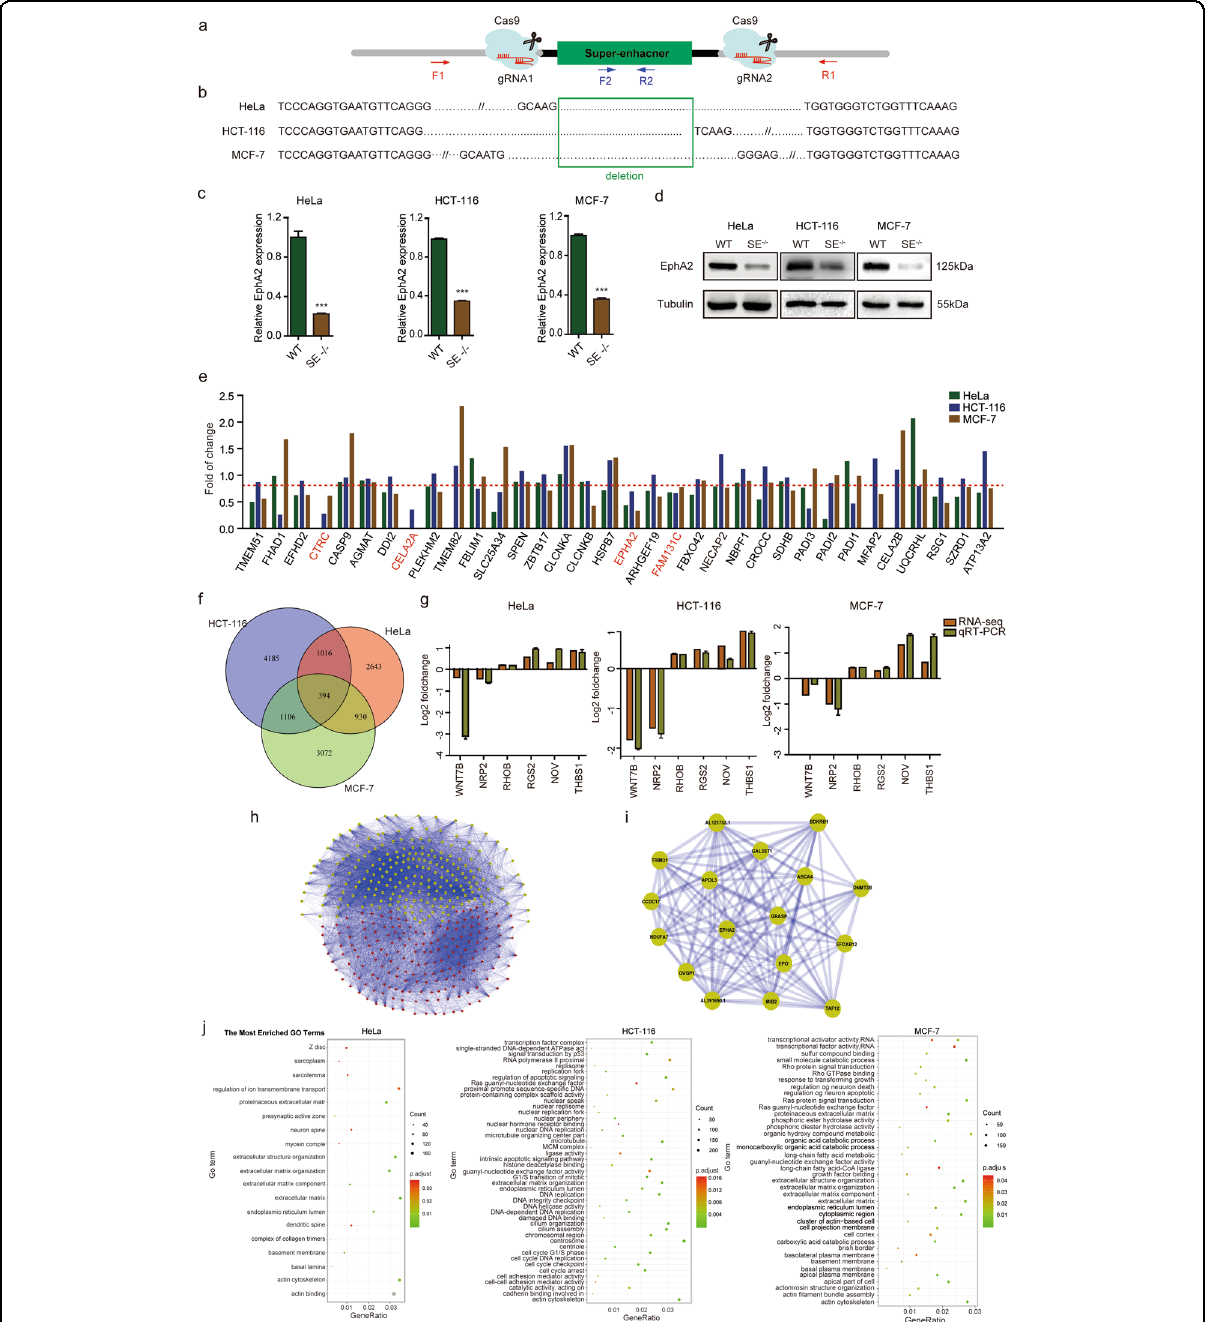
Fig. 2 CRISPR/Cas9-mediated deletion of EphA2-SE and RNA-seq of EphA2-SE. a Schematic of CRISPR/Cas9-mediated deletion of the super- enhancer. b The deletion clones of the super-enhancer were identi fi ed through sequencing results. c The expression level of EphA2 in EphA2-SE- knockout cells was signi fi cantly decreased by qRT-PCR and d western blotting. Relative expression level was normalized by GAPDH. Error bars, mean ± SD. n = 3. p values were calculated using t -test. *** p < 0.001. e RNA-seq analyzes the gene expression of EphA2-SE within ~1 Mb. f Venn diagram of up-regulated genes and downregulated genes in HeLa, HCT-116 and MCF-7 cells (fold change >1.2 or <0.83). g Validation of RNA-seq analysis in EphA2-SE (SE − / − ) clones. h Co-expression network map of 394 public differentially expressed genes. i A module with EphA2 as the core in co- expression network. j GO enrichment analysis of differentially expressed